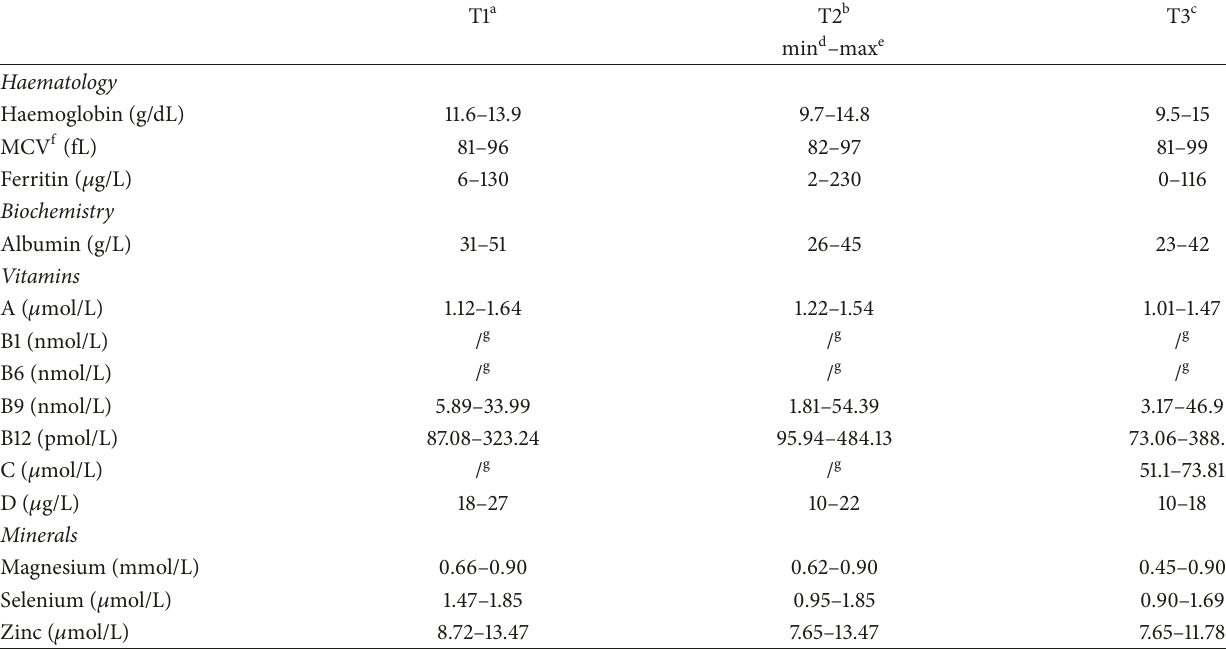
Table 1: Biological standards for haematological, biochemical, and micronutritional parameters in pregnant